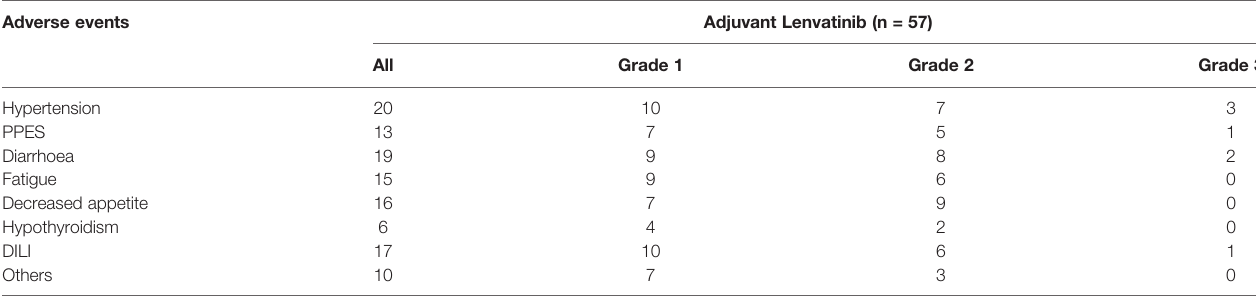
TABLE 2 | Adverse events in treatment of adjuvant Lenvatinib after radical resection and their corresponding common terminology criteria for adverse events (CTCAE) grade. Adverse events Adjuvant Lenvatinib (n = 57) All Grade 1